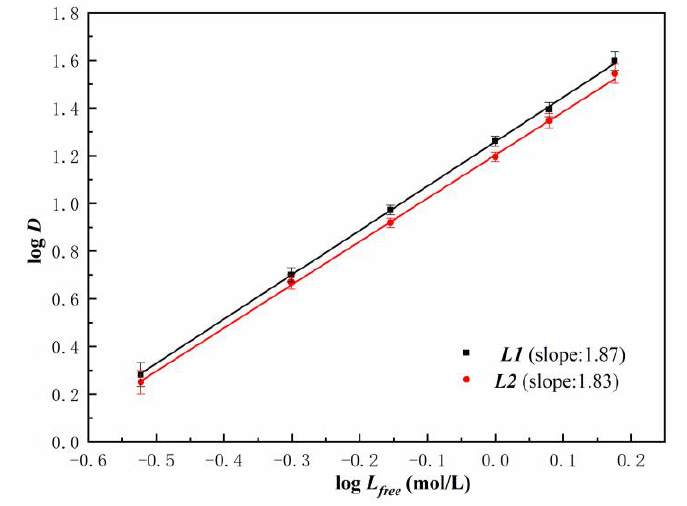
Figure 4. D U by two ligands in n-dodecane as a function of L concentration ([HNO 3 ] ini = 5 mol/L, [U(VI)] ini = 10 g / L).